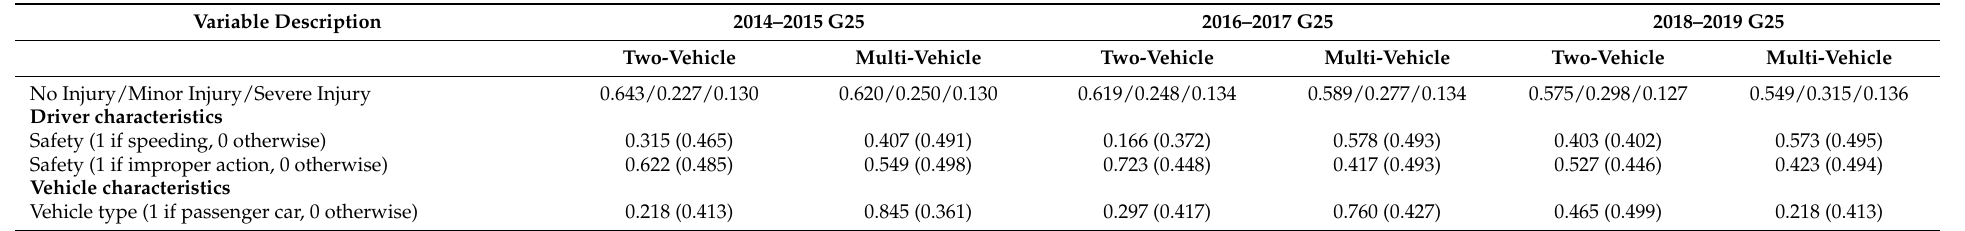
Table 2. Descriptive statistics of variables in two-vehicle and multi-vehicle freeway rear-end crashes in Beijing-Shanghai Freeway (G25) (Std. Dev. in